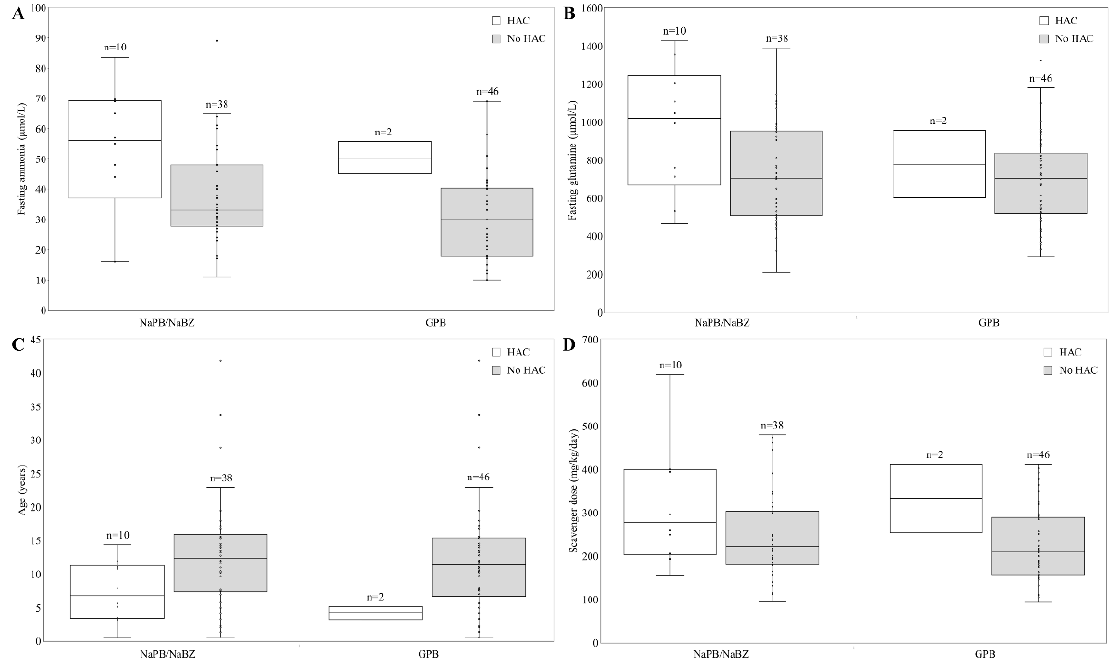
Figure 1. Characteristic of patient suffering hyperammonemic crisis (HAC). ( A ) Fasting ammonia levels (µmol/L) in patients with or without HAC treated with GPB or other nitrogen scavenger (NaPB/NaBZ). ( B ) Fasting glutamine levels (µmol/L) in those patients. ( C ) Age (years) of patients with or without HAC. ( D ) Scavenger dose received in patients with or without HAC. NaPB: sodium phenylbutyrate; NaBZ: sodium benzoate; GPB: glycerol phenylbutyrate. * Statistically significant. There were 19 patients who visited the emergency room due to 43 episodes prior to switching (39.6%, rate 0.9, SD: 1.4) compared to 11 patients and 14 visits during GPB treat- ment (22.9%, rate 0.3, SD: 0.6, p = 0.004).